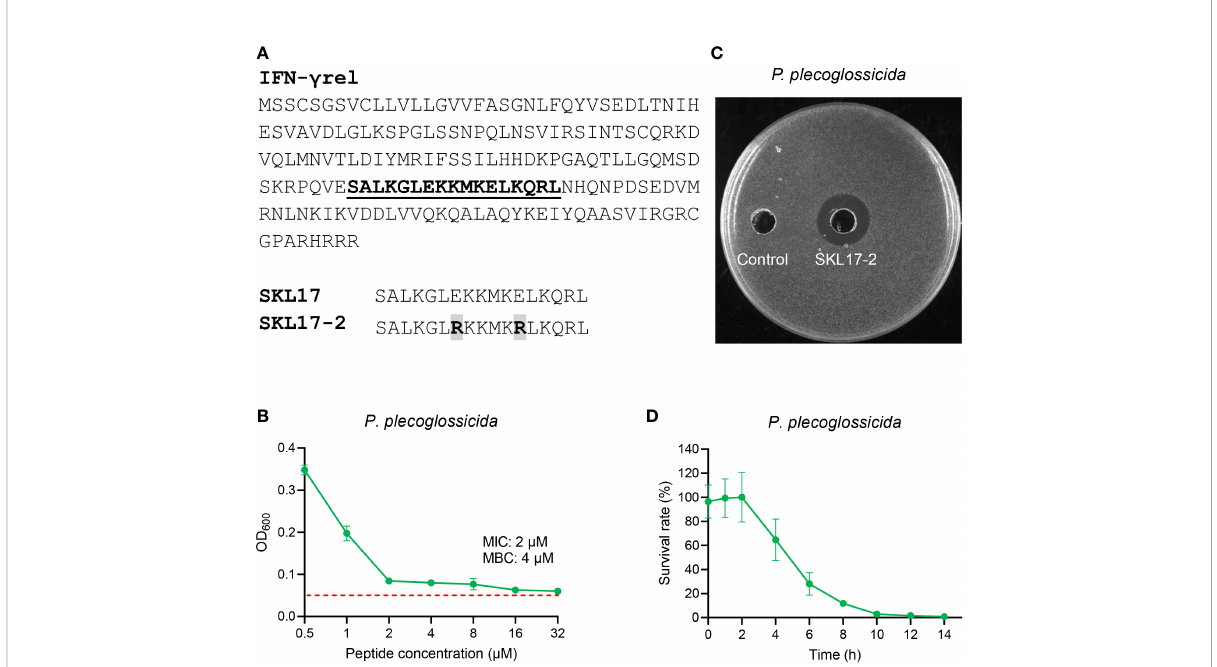
FIGURE 2 Antimicrobial activity of SKL17-2 against P. plecoglossicida . (A) Peptide sequence of SKL17-2. (B) Antimicrobial activity of SKL17-2 against P. plecoglossicida . The red dotted line represents the absorbance values of the medium. (C) SKL17-2 inhibition zone against P. plecoglossicida . (D) Time-kill kinetic curves of the SKL17-2 against P. plecoglossicida at 1×MBC. The kinetic graphs were the mean values of three independent